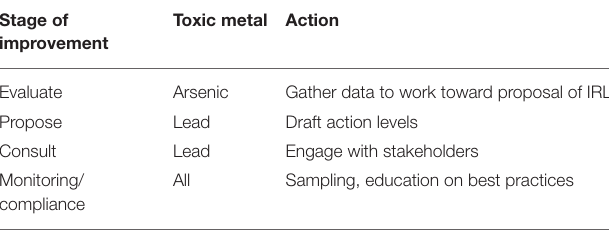
TABLE 6 | Phase 1 FDA’s Closer to Zero Action Plan: April 2021 - April 2022.